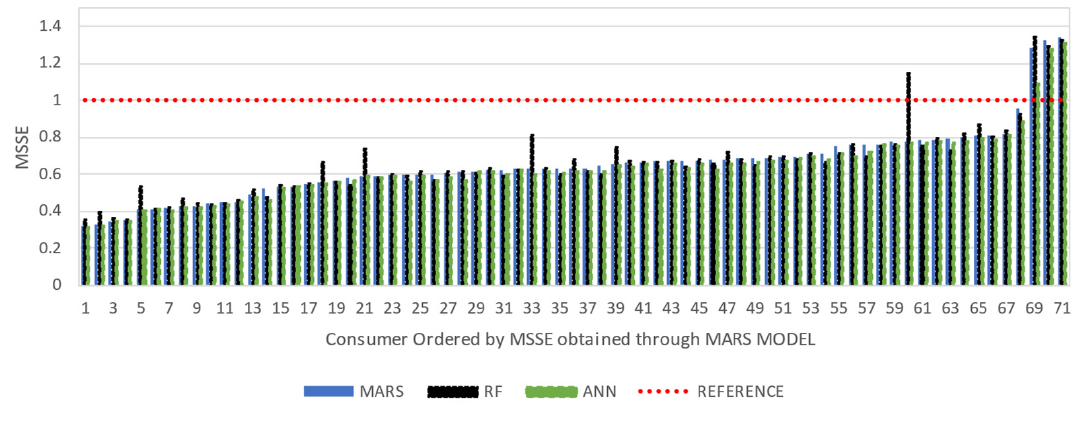
Figure 9. MSSE comparison per consumer ID.